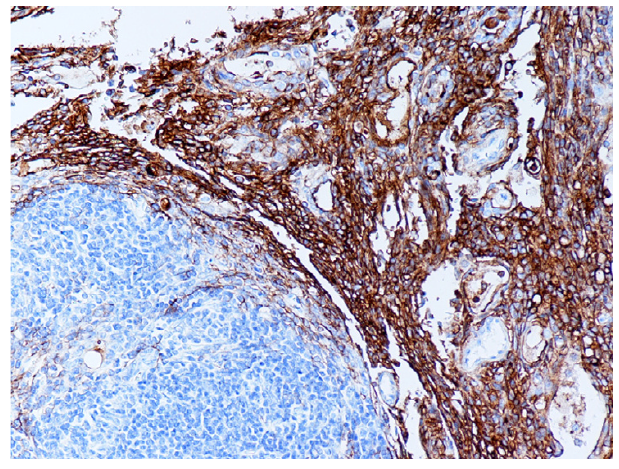
Figure 4 (B-SA, anti-EMA, × 200): Type AB thymoma. Neoplastic epi- thelial cells in type A component express